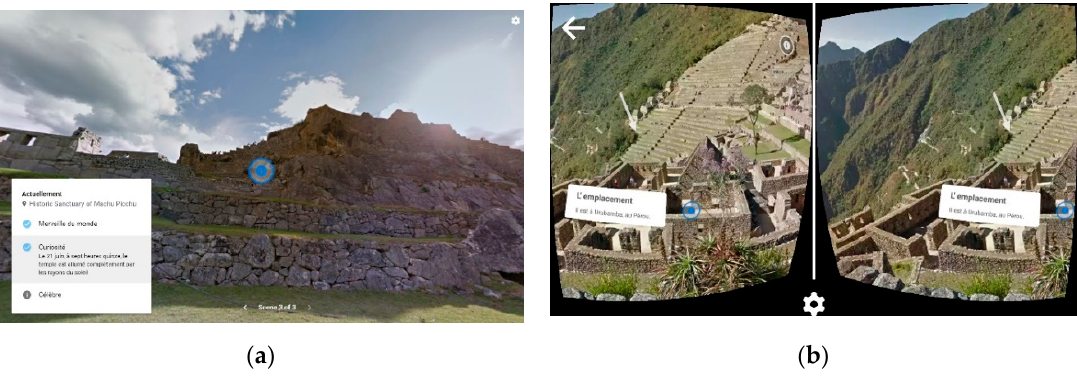
Figure 3. Google Tour Creator (Google LLC, Mountain View, CA, USA, vr.google.com/tourcreator) visualization screen of a student created tour: ( a ) Desktop internet browser screen; ( b ) Smartphone internet browser screen in VR mode.